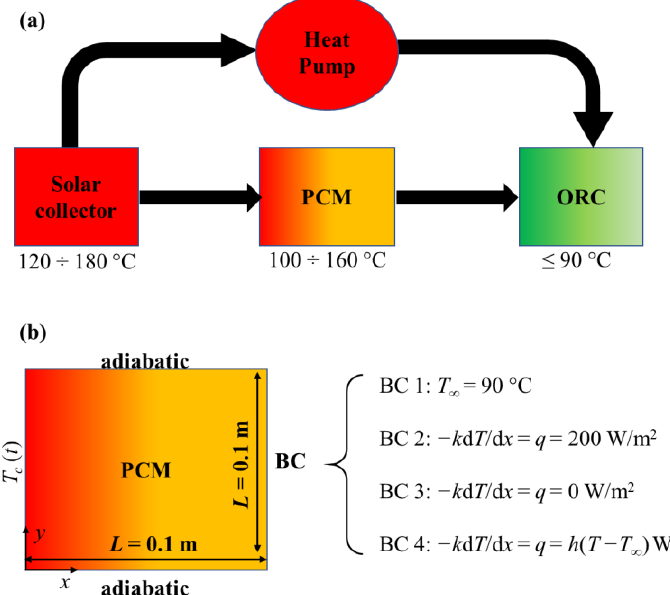
Figure 1. The Phase Change Materials (PCM)-solar-assisted Organic Rankine Cycle (ORC) scheme: ( a ) sketch of the thermal system; ( b ) detailed boundary conditions employed in the present paper.